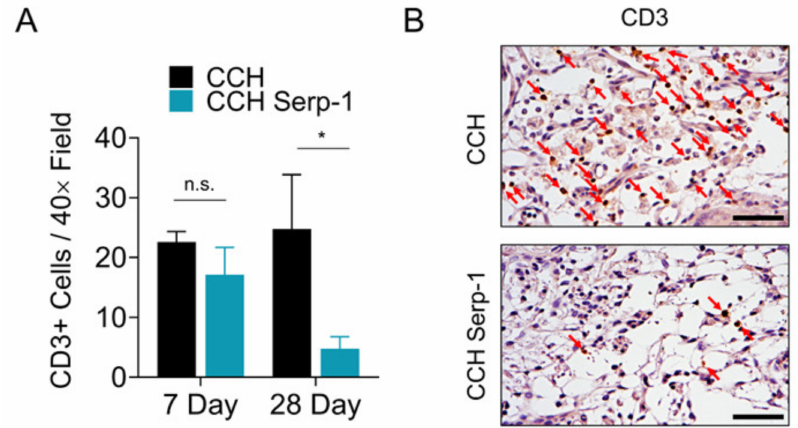
Figure 4. Serp-1 delivered by chitosan-collagen hydrogel decreases T-cell invasion in rat SCI. ( A ) Quantification of CD3 + cells in the area of injury in spinal cords of rats post-SCI treated with 50 µ L chitosan-collagen hydrogel alone or 50 µ L chitosan-collagen hydrogel with 100 µ g Serp-1 at days 7 and 28 after injury. Mean and standard error are presented. Statistics performed by Two-Way ANOVA with Fisher’s LSD post-hoc where * p < 0.05 and n.s. is not significant. ( B ) Representative immunohistochemical staining (brown) of CD3 + cells at day 28 of the same conditions quantified in panel A. Red arrows indicate cells positive for active CD3. Scale bars are 25 µ